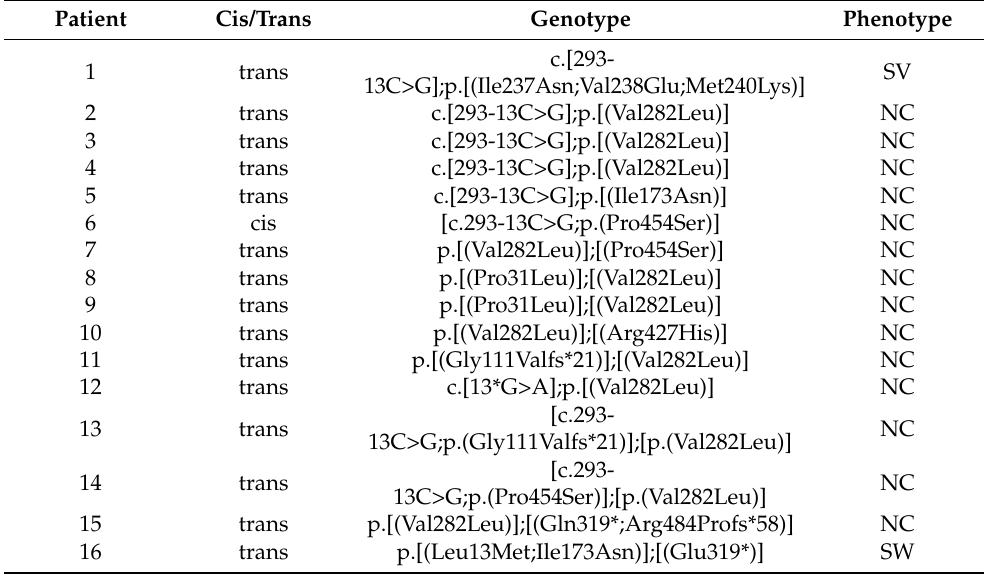
Table 3. Allelic distribution of the point-pathological variants in patients without their parents’ genetic